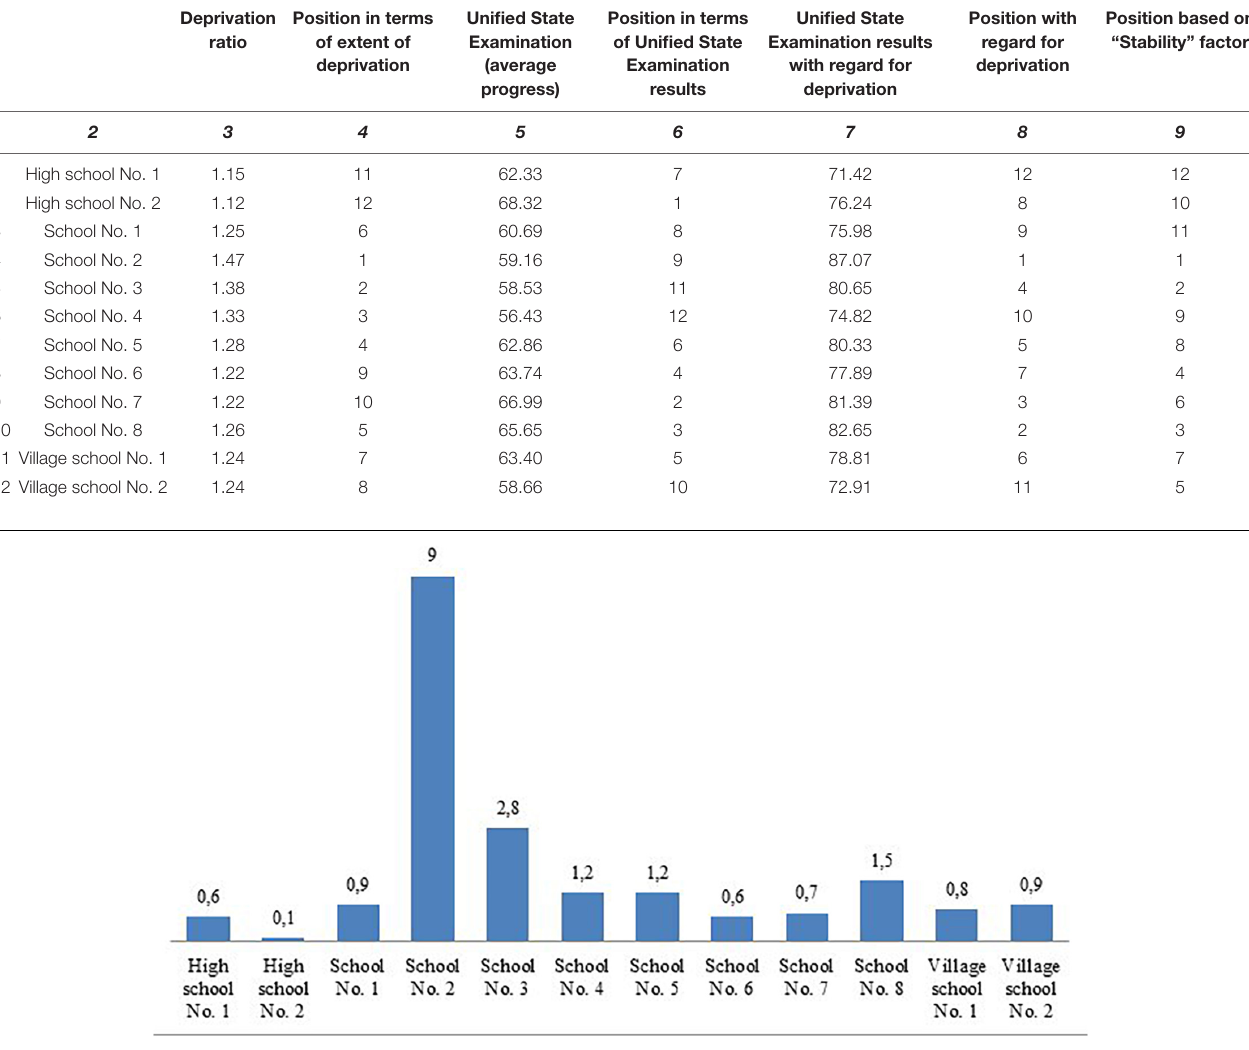
TABLE 2 | Correlation of deprivation ratios, results of educational work at schools and their stability.